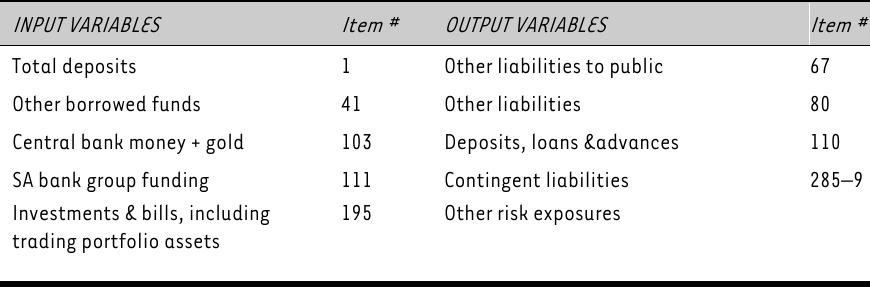
TABLE 4: The input and output variables for measuring relative liquidity efficiency INPUT VARIABLES